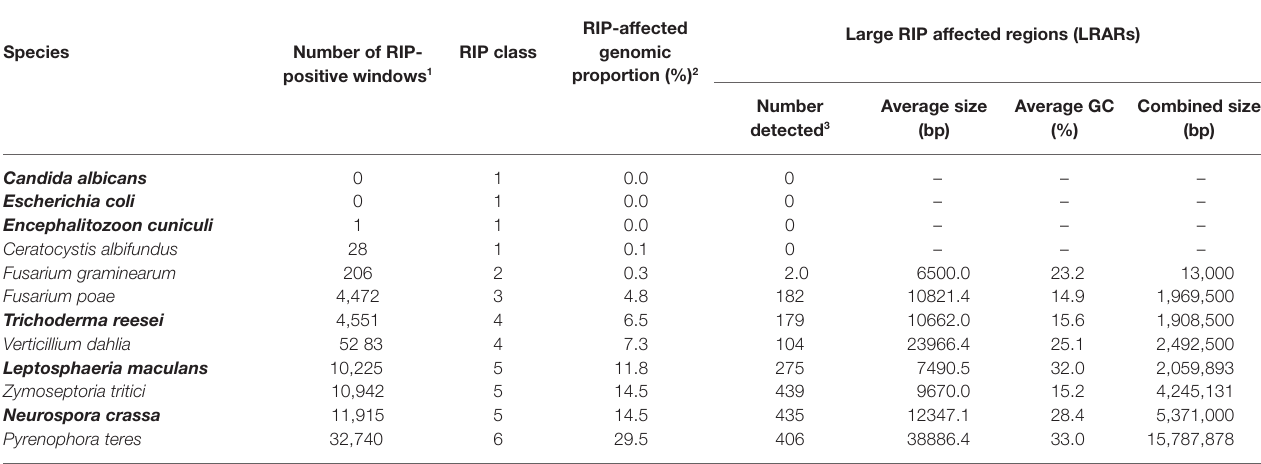
TABLE 2 | A summary of genome-wide RIP statistics of representatives of each RIP class and control genome assemblies investigated in this study.